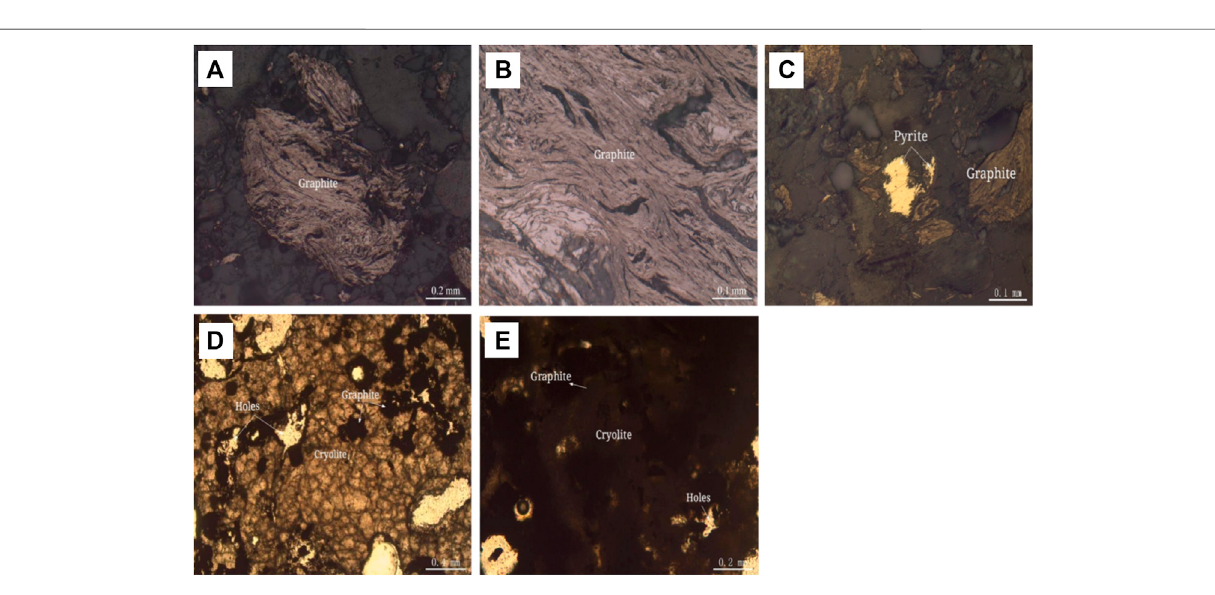
FIGURE2| StructureDiagramofAnodeCarbonresidue. (A) Flakeand fi brousgraphiteaggregatesarelumpyinre fl ectedplanepolarizedlight. (B) Flakeand fi brous graphite is lumpy in re fl ected plane polarized light. (C) Pyrite is anamorphic granular in re fl ected plane polarized light. (D) Cryolite is microscopic granular amorphous, grainboundariesareblurred,closelyinlaid,graphiteaggregatesembeddedinthem,transmissionofsinglepolarizedlight. (E) cryoliteismud-microcrystalline,particlesize < 0.004 mm, or 0.004 – 0.03 mm, transmission of single polarized light.